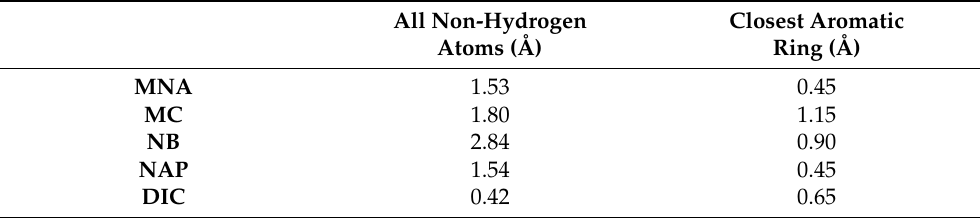
Table 1. Distance between the crystallographic ligand (MEF) and docking poses of the ligands, calculated among the geometric centers of the selected region. All Non-Hydrogen Closest Atoms (Å)